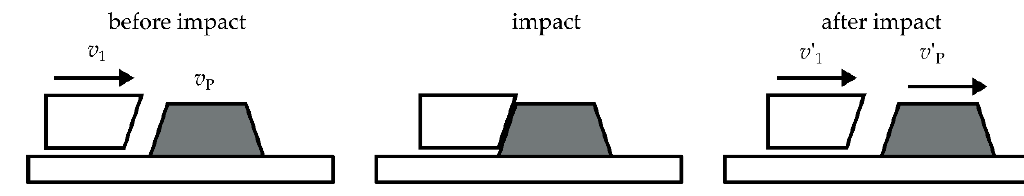
Figure 5. Model to verify the coefficient of restitution.